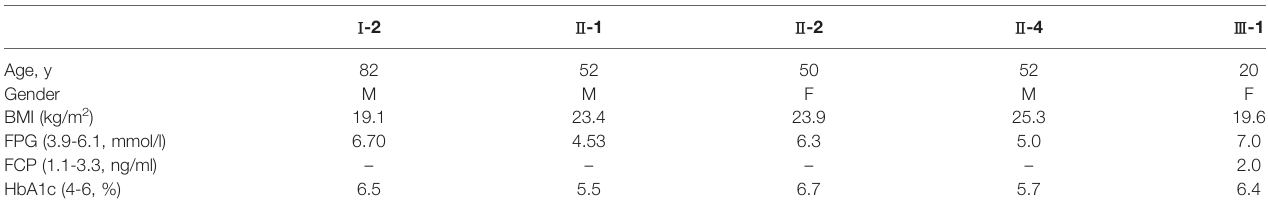
TABLE 1 | Physical and laboratory examination.